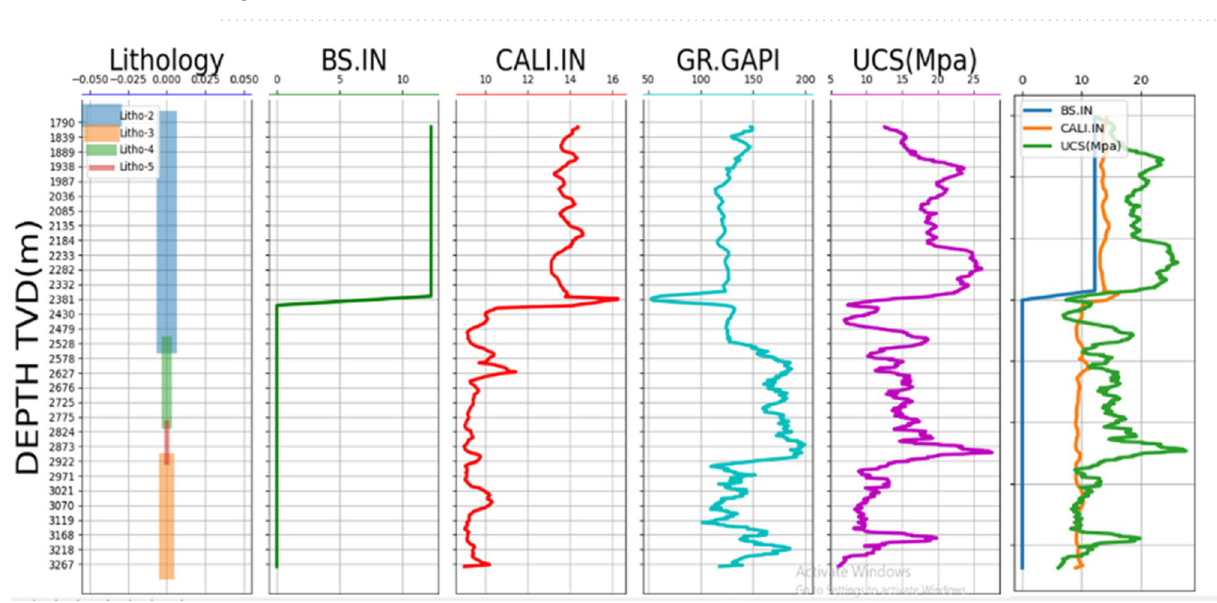
Figure 12. 1D Mechanical earth